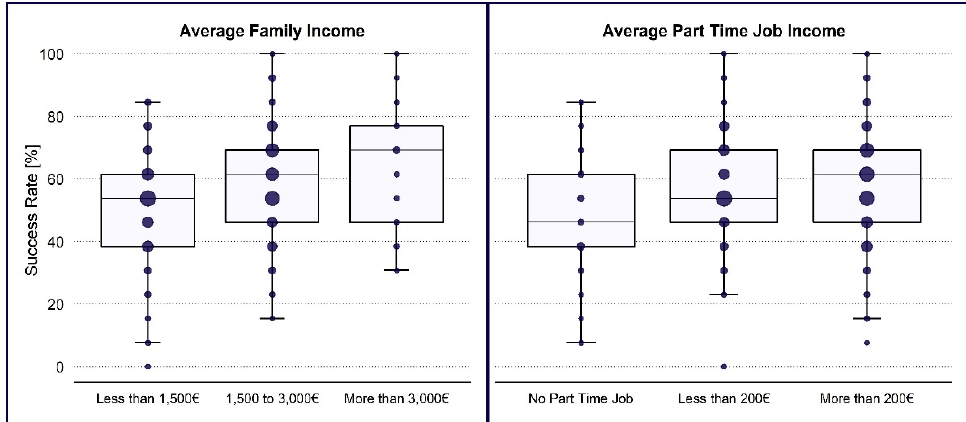
Figure 4. Success rate of students in the financial literacy test depending on the family’s economic Figure background.